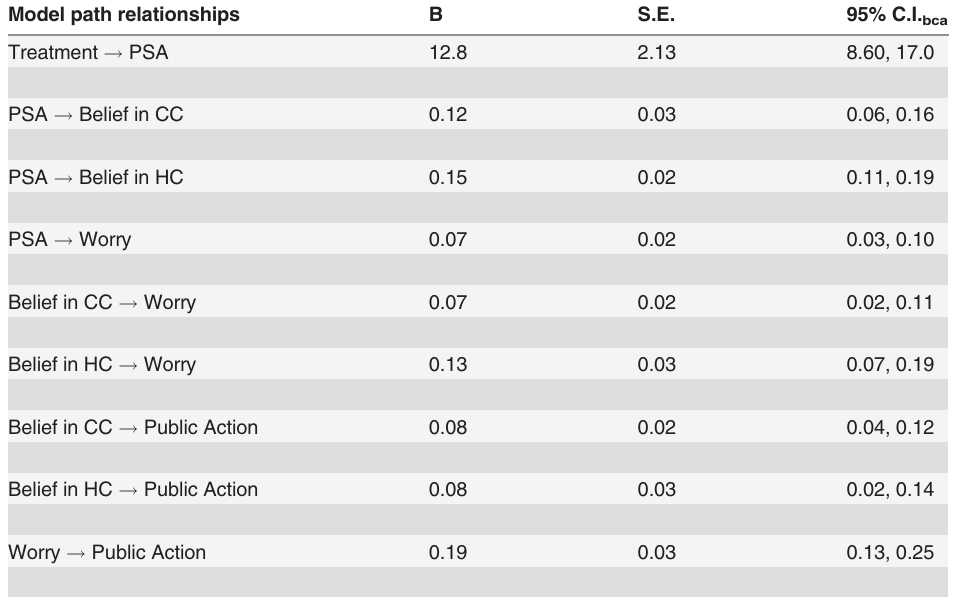
Table 2. SEM model parameters. Model path